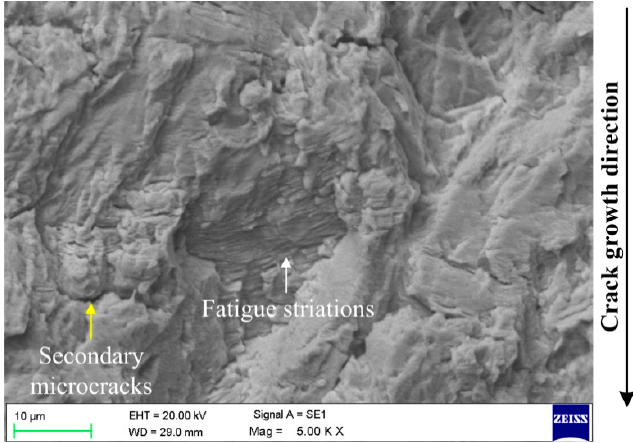
Figure 16. Fatigue fracture surface morphologies at a > 1 mm: ( a ) LD1 specimen; ( b ) TD1 specimen.